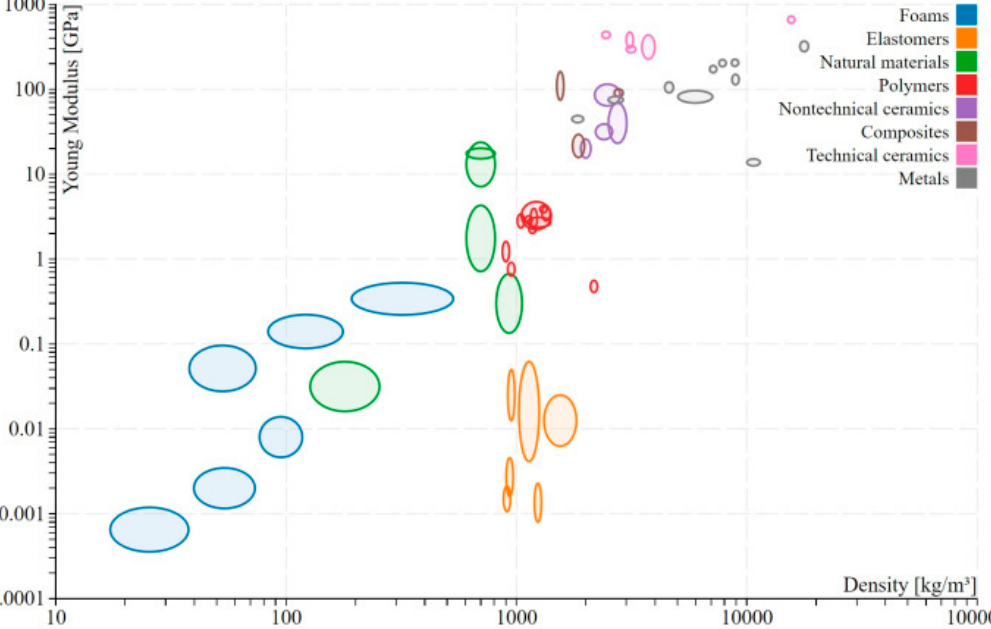
Figure 3. The “Ashby” plot for Young’s modulus (Y-axis) and density (X-axis) is an effective tool in material selection but does not isolate geometry from composition for cellular materials (Attr: Nicoguaro, Wikimedia Commons).